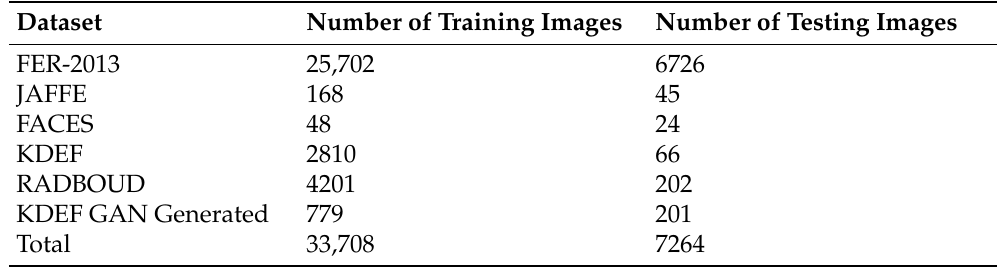
Table 1. Breakdown of data for the created